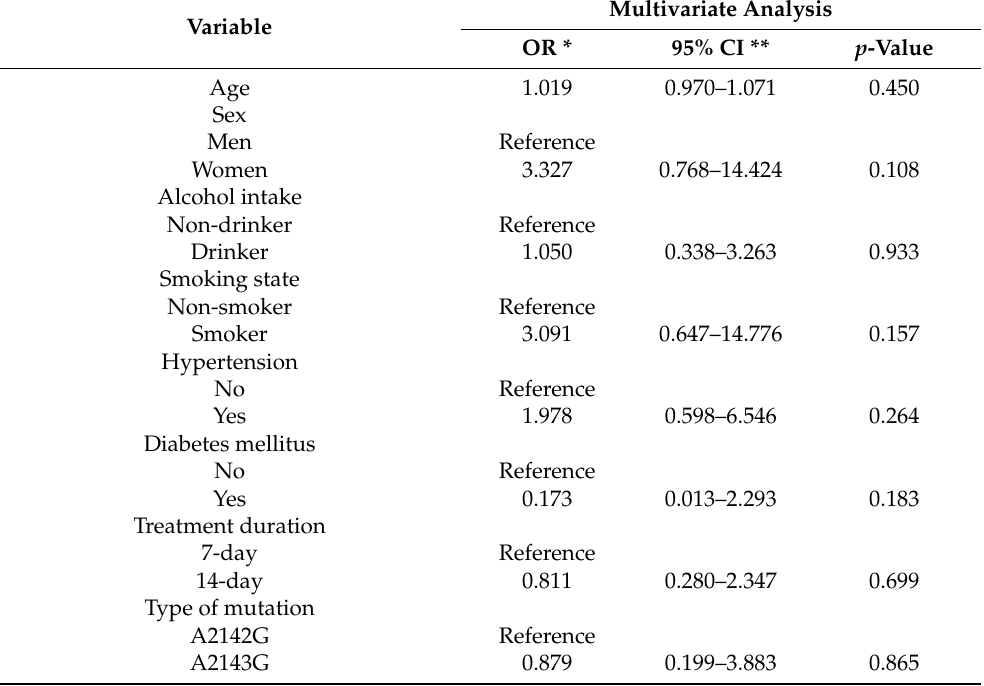
Table 4. Clinical factors associated with H. pylori eradication.